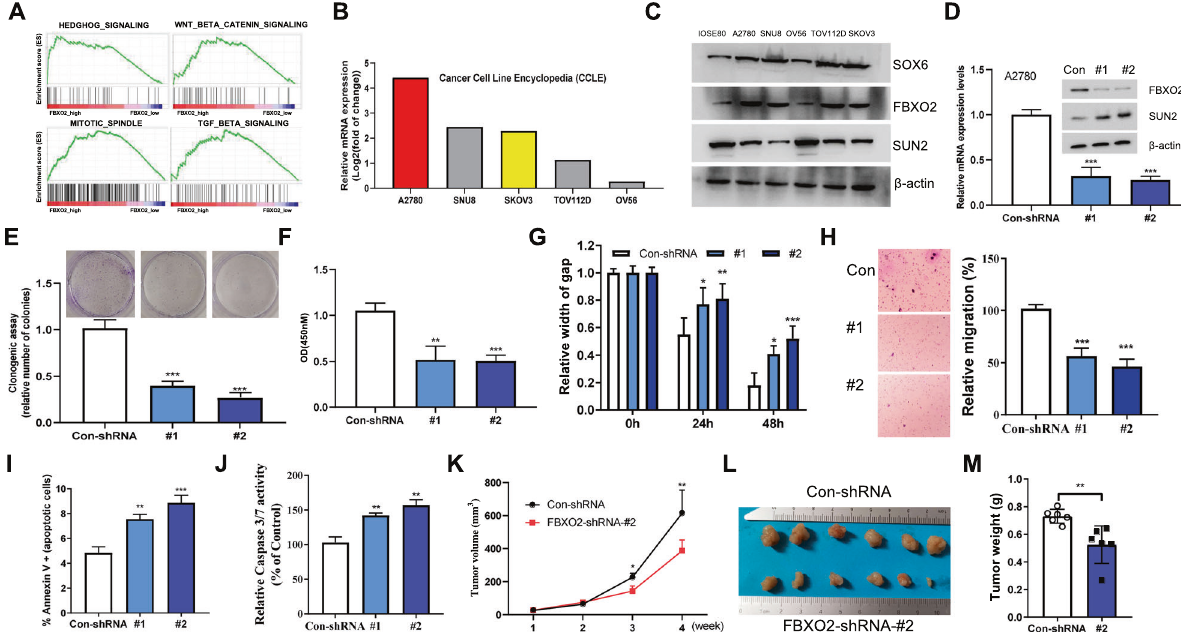
Fig. 3 FBXO2 is required for OV growth both in vitro and in vivo. A Gene set enrichment analysis (GSEA) showed the enrichment of several signaling pathways in the FBXO2 high expressing OV tissues from TCGA OV database. B Relative FBXO2 mRNA expression in several OV cell lines obtained through the CCLE website. C The lysates of the indicated OV cells were immunoblotted with indicated antibodies. D The mRNA and protein levels of FBXO2 in A2780 cells stably expressing Con-shRNA or FBXO2-shRNA were determined by real-time PCR and immunoblotting, respectively. E Quanti fi cation of a colony-formation assay of the A280 cells from ( D ). F Cell proliferation in A2780 cells from ( D ) assessed by CCK-8 assay after 72 h. G The gap width in A2780 cells from ( D ) was measured at 24 h and 48 h, respectively. H The relative migration rate of A2780 cells from ( D ). I A2780 cells transfected with or without FBXO2-speci fi c shRNAs were analyzed by FACS with Annexin V-PI assay. The graph represents the percentage of Annexin V positive cells. J Caspase3 and Caspase7 activity were measured in A2780 cells transfected with or without FBXO2-speci fi c shRNAs. The y -axis indicates the caspase3 and caspase7 activity over cell number. The value given for the caspase activity in control-infected cells was set as 100. K The growth curves of xenograft tumors derived from